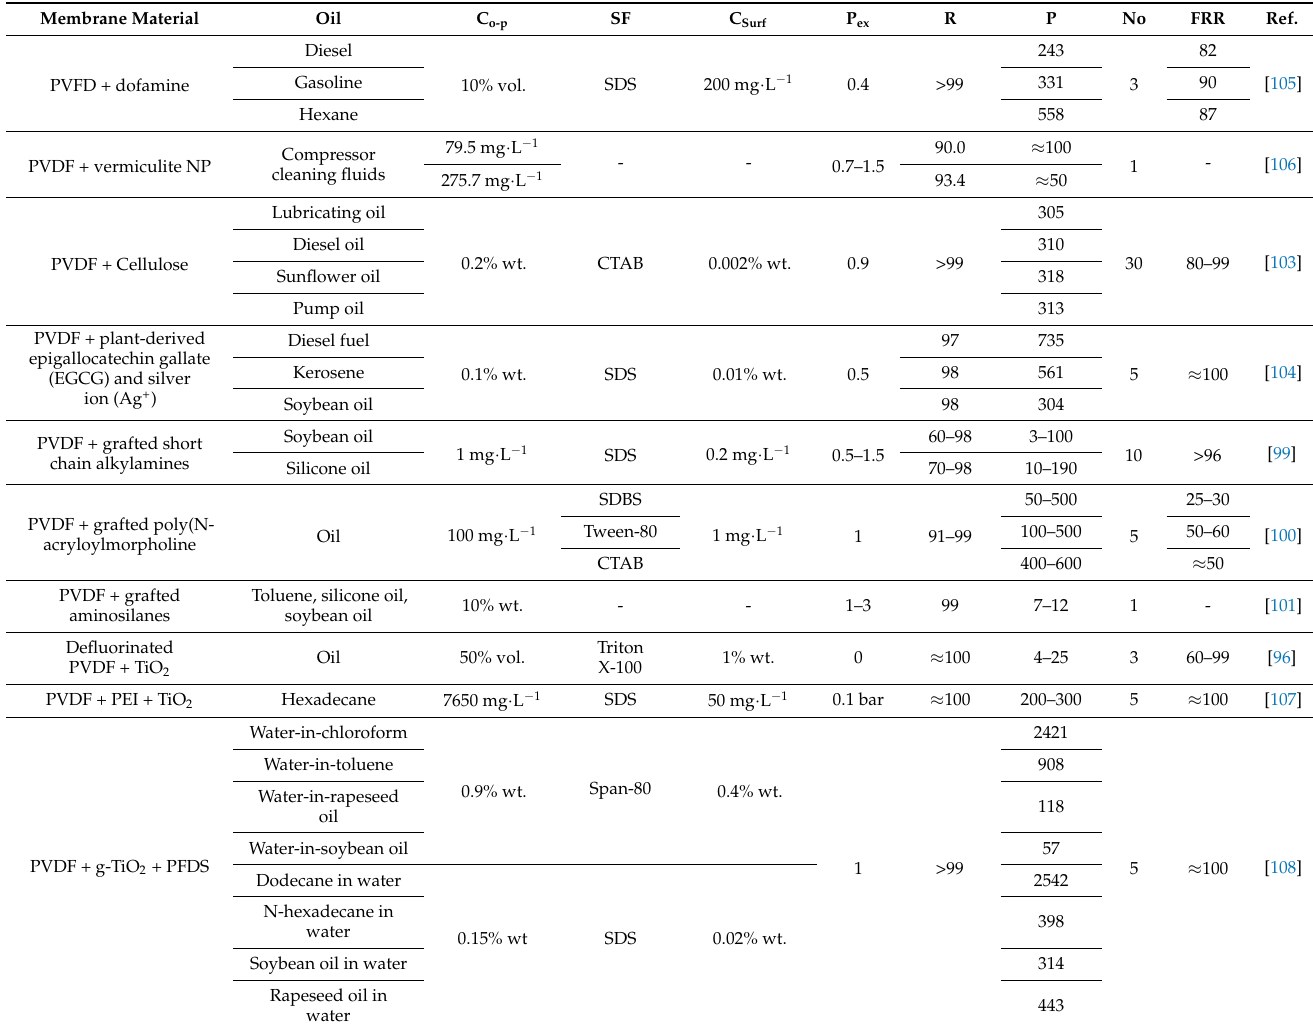
Table 5. PVDF-based membranes for the separation of water-oil